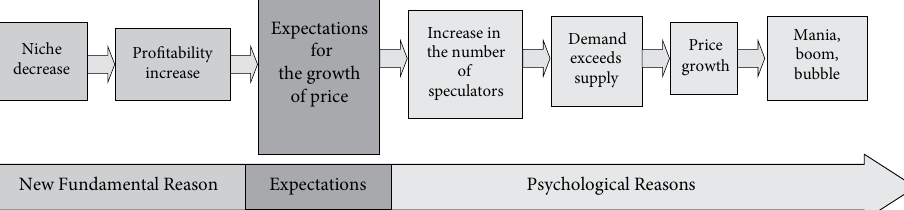
Fig. 5. The scheme of formation of bubbles (Moskaliova, Girdzijauskas